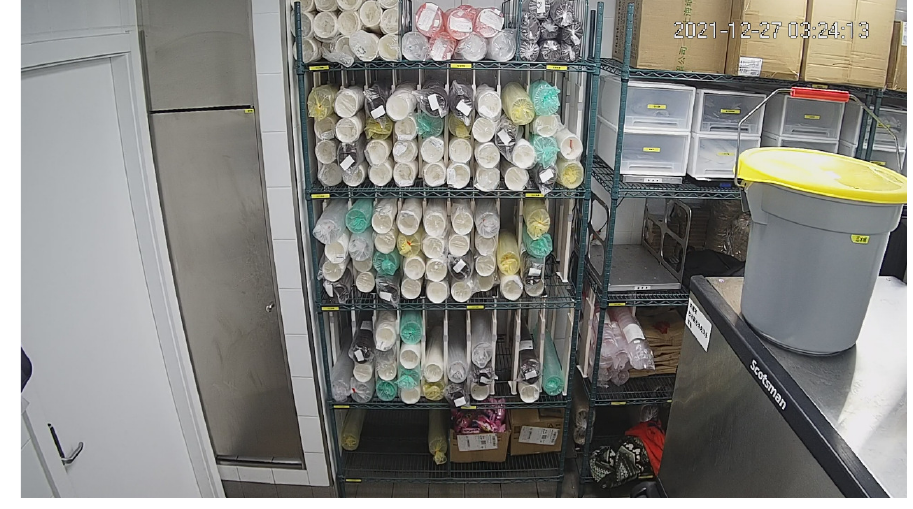
Figure 4. Warehouse scenario in our task.